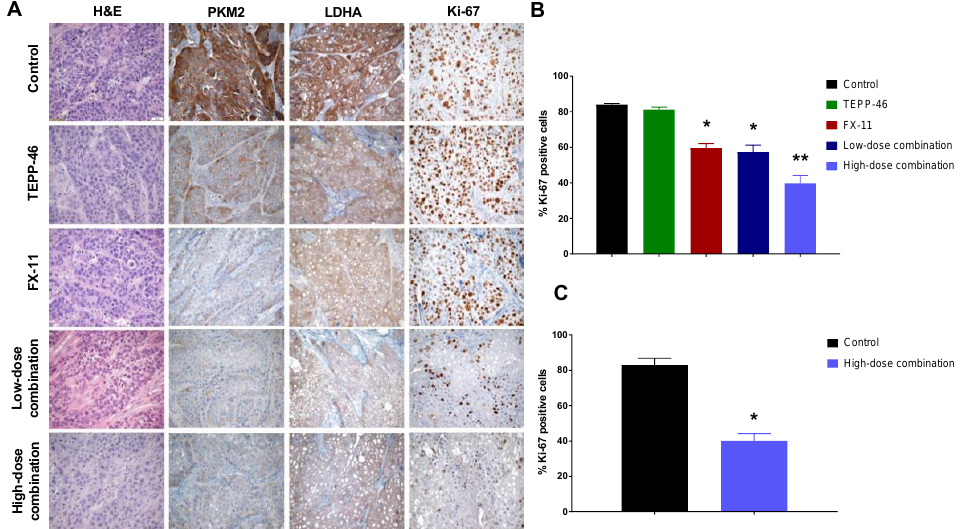
Figure 6. Detection of inactive PKM2 and LDHA and Ki-67 expression in response to TEPP-46, FX-11, and combination treatment. ( A ) Representative images of tumor sections from each group from the subcutaneous tumor model stained with H&E, PKM2, LDHA, and Ki-67 (40 × magnification). Scale bar: 20 µ m; Proliferation indices in response to treatment in the ( B ) subcutaneous and ( C ) orthotopic tumor model. PKM2 detection and LDHA expression were lower in tumor sections from all treatment groups compared with controls. Ki-67 expression was significantly lower in the FX-11, low- and high-dose combination treatment groups compared with controls, and significantly lower in the high-dose combination group compared with all other treatments. Significantly decreased proliferation indices were observed in tumor sections from the high-dose combination treatment compared with controls in the orthotopic tumor model. Data presented as mean ± SE. * indicates significantly di ff erent from controls; ** indicates significantly di ff erent from controls and all other treatment